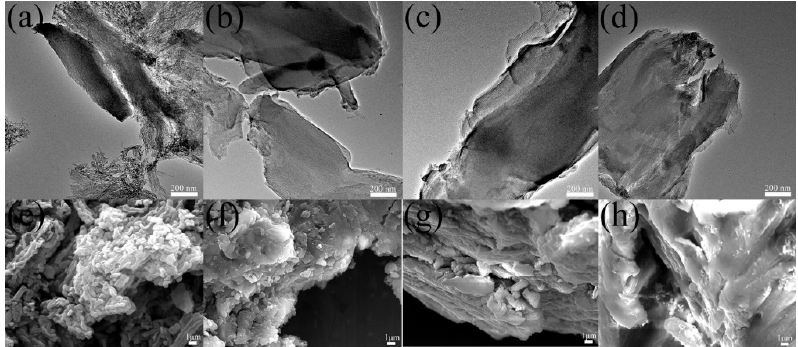
Figure 2. TEM and FESEM image of CMK-3 and OMC-CS-4,6,8: ( a , e ) CMK-3, ( b , f ) OMC-CS-4, ( c , g ) OMC-CS-6, and ( d , h ) OMC-CS-8.